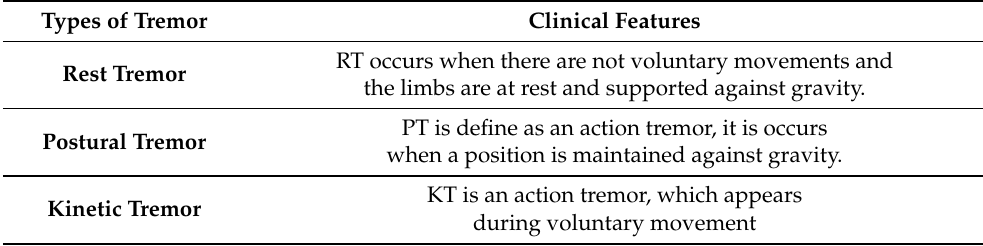
Table 4. Adopted types of tremors: main features. Types of Tremor